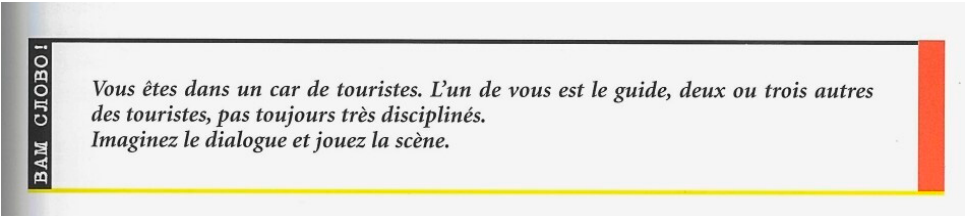
Languages 2023 , 8 , x FOR PEER REVIEW Figure 1. Example 1 of a task in Reportazh . Figure 1. Example 1 of a task in Reportazh .